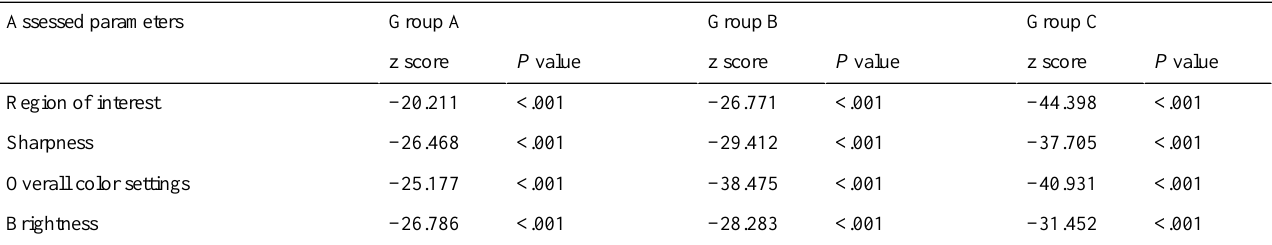
Table 3. Unpaired rank sum, 2-sided Mann-Whitney U (Cronbach alpha=.05) for ratings of images taken with Google Glass and Nikon D3200 reflex camera for each group for each of the 4 assessed parameters.